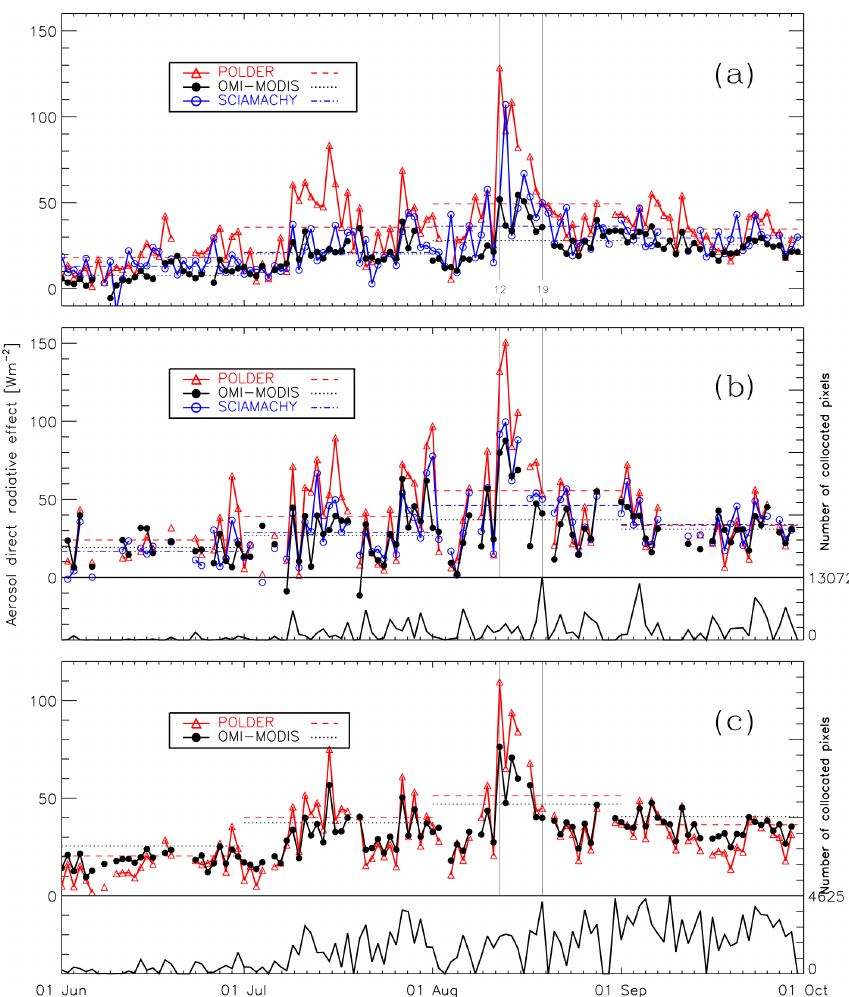
Figure 2. (a) Noon-normalized instantaneous aerosol DRE over clouds from combined OMI–MODIS reflectances (black), SCIAMACHY reflectances (blue), and POLDER AOT and COT retrievals (red) from 1 June to 1 October 2006, averaged over the area 10 ◦ N–20 ◦ S, 10 ◦ W– 20 ◦ E in the south-east Atlantic. The average monthly aerosol DREs over clouds are given by the coloured straight lines during each month. (b) Same as (a) , but for OMI–MODIS and SCIAMACHY pixels that were regridded to the 6km × 6km POLDER grid. Averaged values were only calculated from grid points that were covered by all three instruments. The number of collocated pixels that are covered by all three instruments is given in the lower panel in (b) . (c) Area-averaged instantaneous aerosol DRE from OMI–MODIS and POLDER regridded to the OMI footprint. Note that because SCIAMACHY is omitted the number of pixels is much larger than in (a) and (b) , and furthermore, the DRE is not noon-normalized, because the overpass times of OMI, POLDER and MODIS are